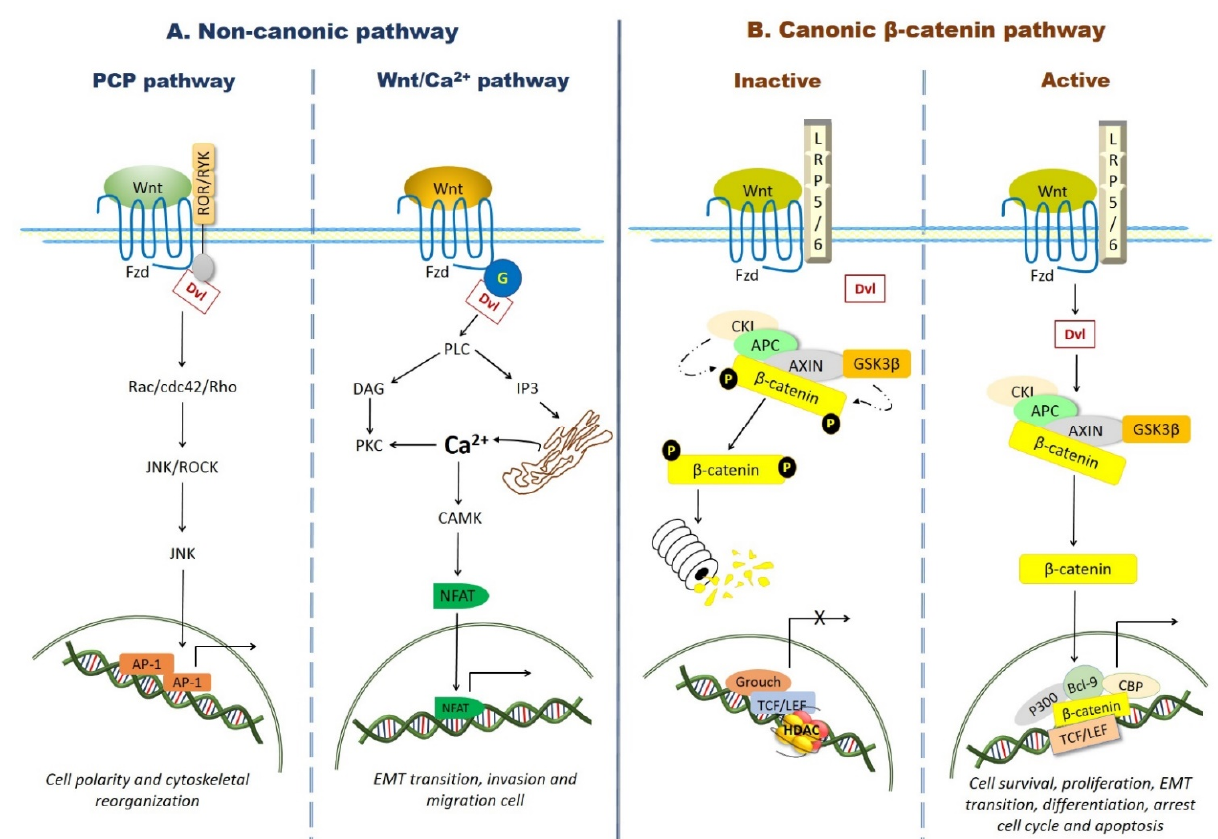
Figure 1. Non-canonical and canonical Wnt pathways. In the non-canonical Wnt/PCP and Wnt/Ca 2+ pathway ( A ), the interaction of Wnt/Fzd/ROR and RYK promotes the activation of small GTPases like Rac1, Cdc42, and RhoA, which activate JNK and ROCK, inducing cell polarity and cytoskeletal reorganization through the expression of the target gene induced by the AP-1 transcriptional factor (PCP pathway). The interaction of Wnt/Fzd with G proteins induces the activation of PLC, promoting the cleavage of PIP 2 to DAG and PIP 3 , causing the activation of PKC and calcium release by IP 3 from the endoplasmic reticulum. Calcium activates CAMK, with the subsequent transactivation of NFAT and the regulation of EMT, cell invasion, and migration (Wnt/Ca 2+ pathway). With respect to the canonical Wnt/β-catenin pathway ( B ), in the absence of Wnt ligands, the pathway is turned off. Cytosolic β-Catenin is phosphorylated by a Destruction Complex formed by APC, Axin, CKI, and GSK3β, which lead to its proteasomal degradation. In the nucleus, the transcriptional factors TCF/LEF bind the transcriptional repressors Groucho/HDAC. On the other hand, when activated, Wnt binds Fzd/ Lrp5/6, activating Dvl, which recruits Axin, favoring the dissociation and inactivation of the Destruction Complex and an ensuing cytoplasmic accumulation (and a nuclear accumulation at latter times) of β-catenin; in the nucleus, β-catenin interacts with TCF/LEF and transcriptional coactivators like Bcl-9, CBP, and p300 to transcribe its target genes, regulating cell survival, proliferation, EMT transition, differentiation, cell cycle arrest, and apoptosis. Continue arrows ( ↓ ) indicate activation; arrows with ( ⊥ ) indicate inhibition.